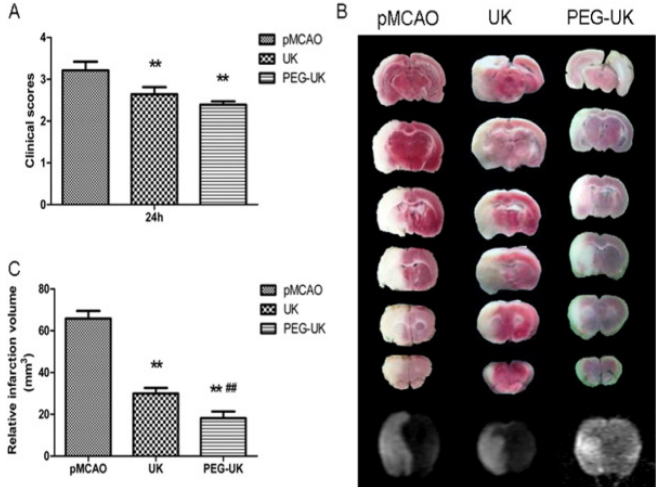
Figure 7. Both urokinase (UK) and PEG-UK reduced neurological deficits. ( A ) The clinical scores. ( B ) Representative images of the threshold of toxicological concern (TTC) straining and diffusion- weighted imaging (DWI) in each group: the infarcted part stained white, whereas the normal part-stained red. ( C ) The mean relative infarction volume of each group. ** p < 0.01 vs. pMCAO; ## p < 0.01 vs. UK. Reproduced from Cui et al. [214] with permission from Elsevier.